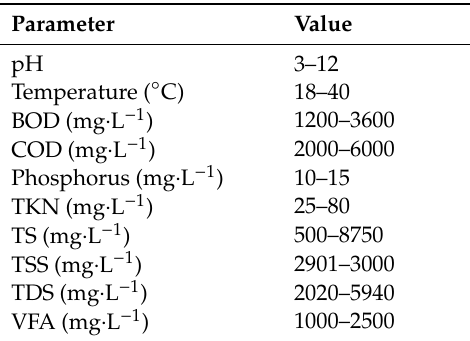
Table 1. Characteristics of the brewery wastewater